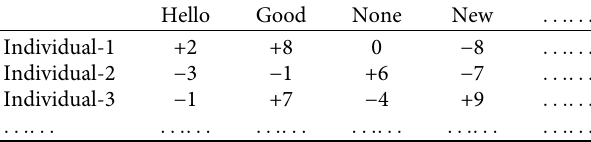
Table 1: An example of initialized